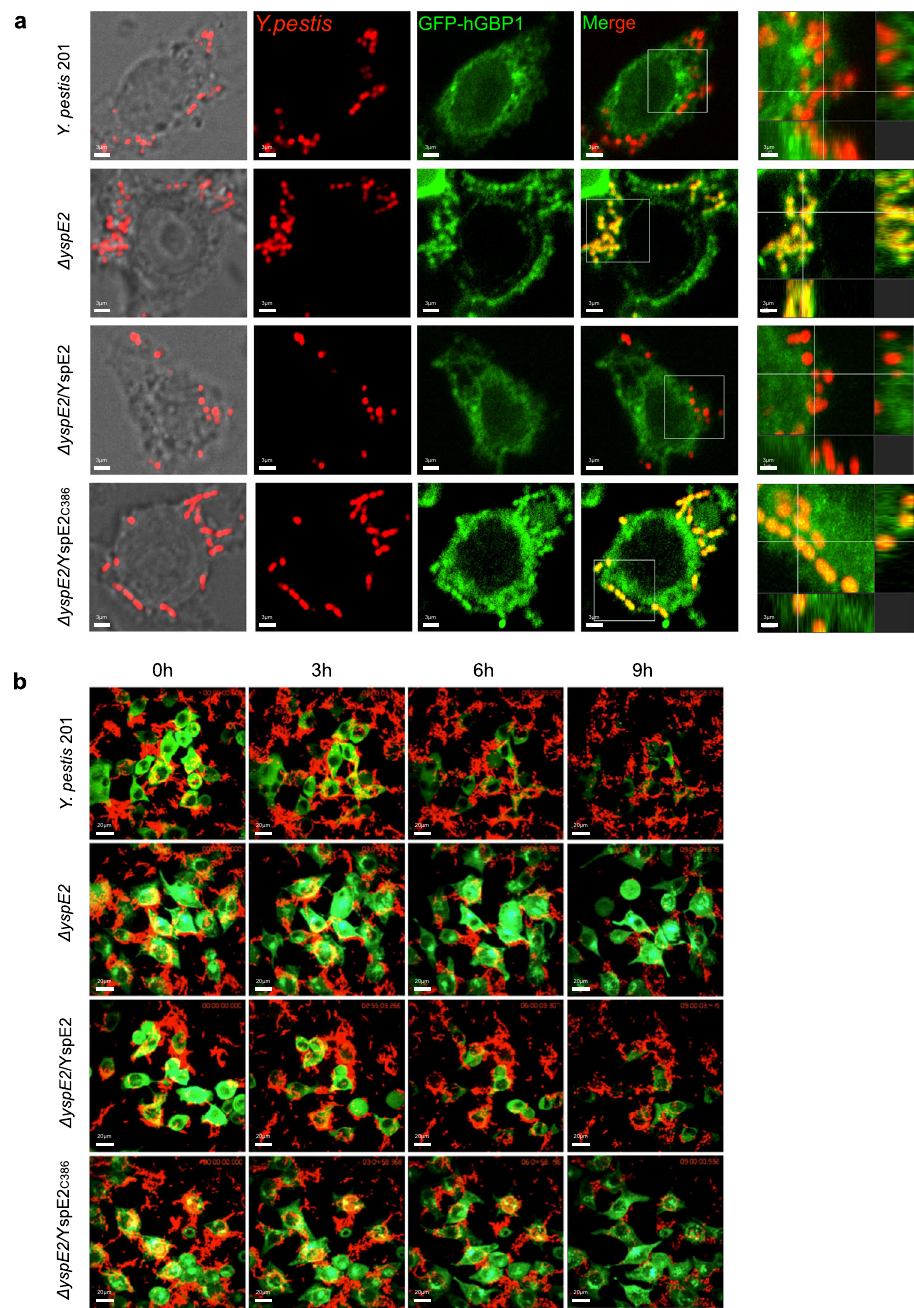
Fig. 6 | Co-localization of Y. pestis Δ yspE2 with hGBP1 dramatically promotes the clearance of bacteria during infection of HeLa cells. a HeLa cells stably expressingGFP-hGBP1wereinfectedwiththeRFP-expressingwildtype Y.pestis 201, Δ yspE2 , Δ yspE2 complementedwiththeplasmidsexpressingYspE2orYspE2 an MOI of 10. After 1h of infection, the confocal micrographs were acquired using an Andor Dragon fl y spinning disk confocal microscope. The far right column showed the 3D reconstruction images from the multiple slice images of the enlarged framed areas. The intracellular bacteria of Y. pestis Δ yspE2 , but not 201,